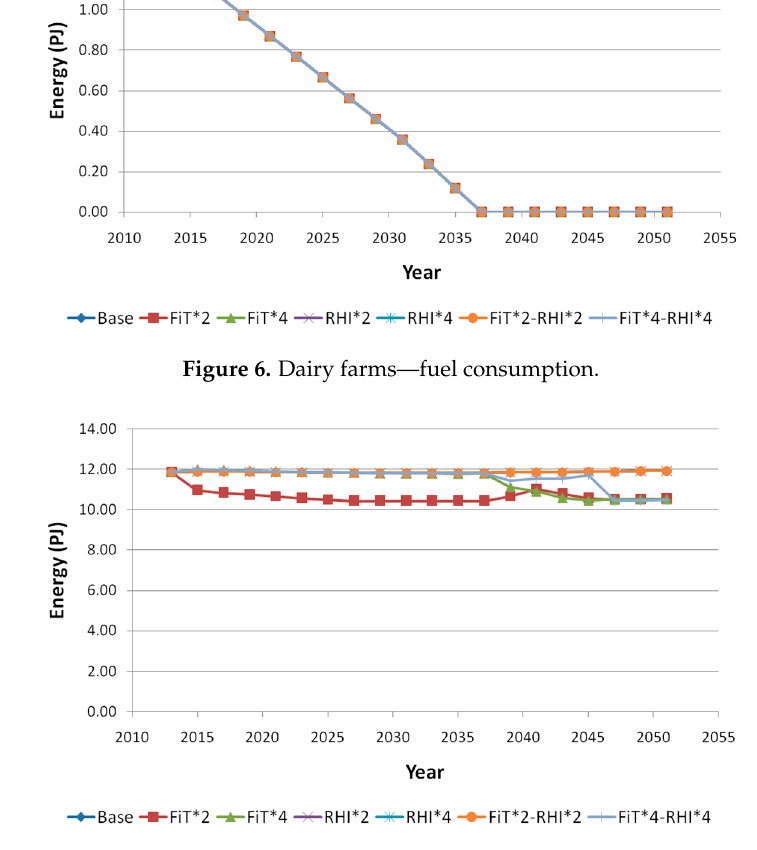
Figure 7. Dairy farms—grid electricity consumption.